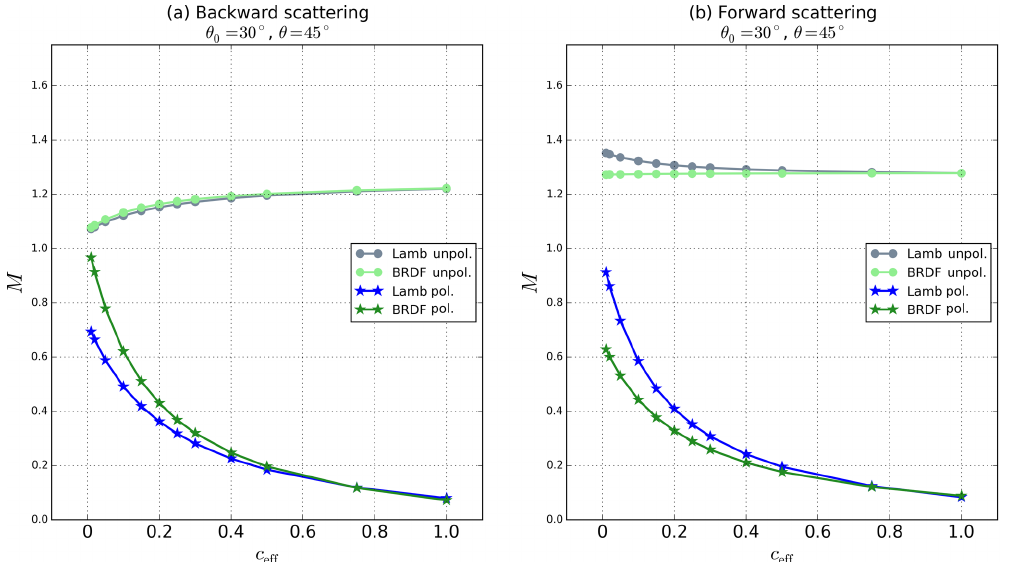
Figure 10. Total tropospheric NO 2 AMF as a function of cloud fraction in the (a) backward-scattering direction and (b) forward-scattering direction computed with surface BRDF (green) and a Lambertian surface (blue), for P cd = 850hPa, ( θ , θ 0 ) = ( 45 ◦ , 30 ◦ ), for a moderately polluted (stars) and unpolluted (circles) troposphere. BRDF parameters are ( f iso , f vol , f geo ) = ( 0 . 04 , 0 . 03 , 0 . 008 ) and A ws = 0 . 036 for the Lambertian